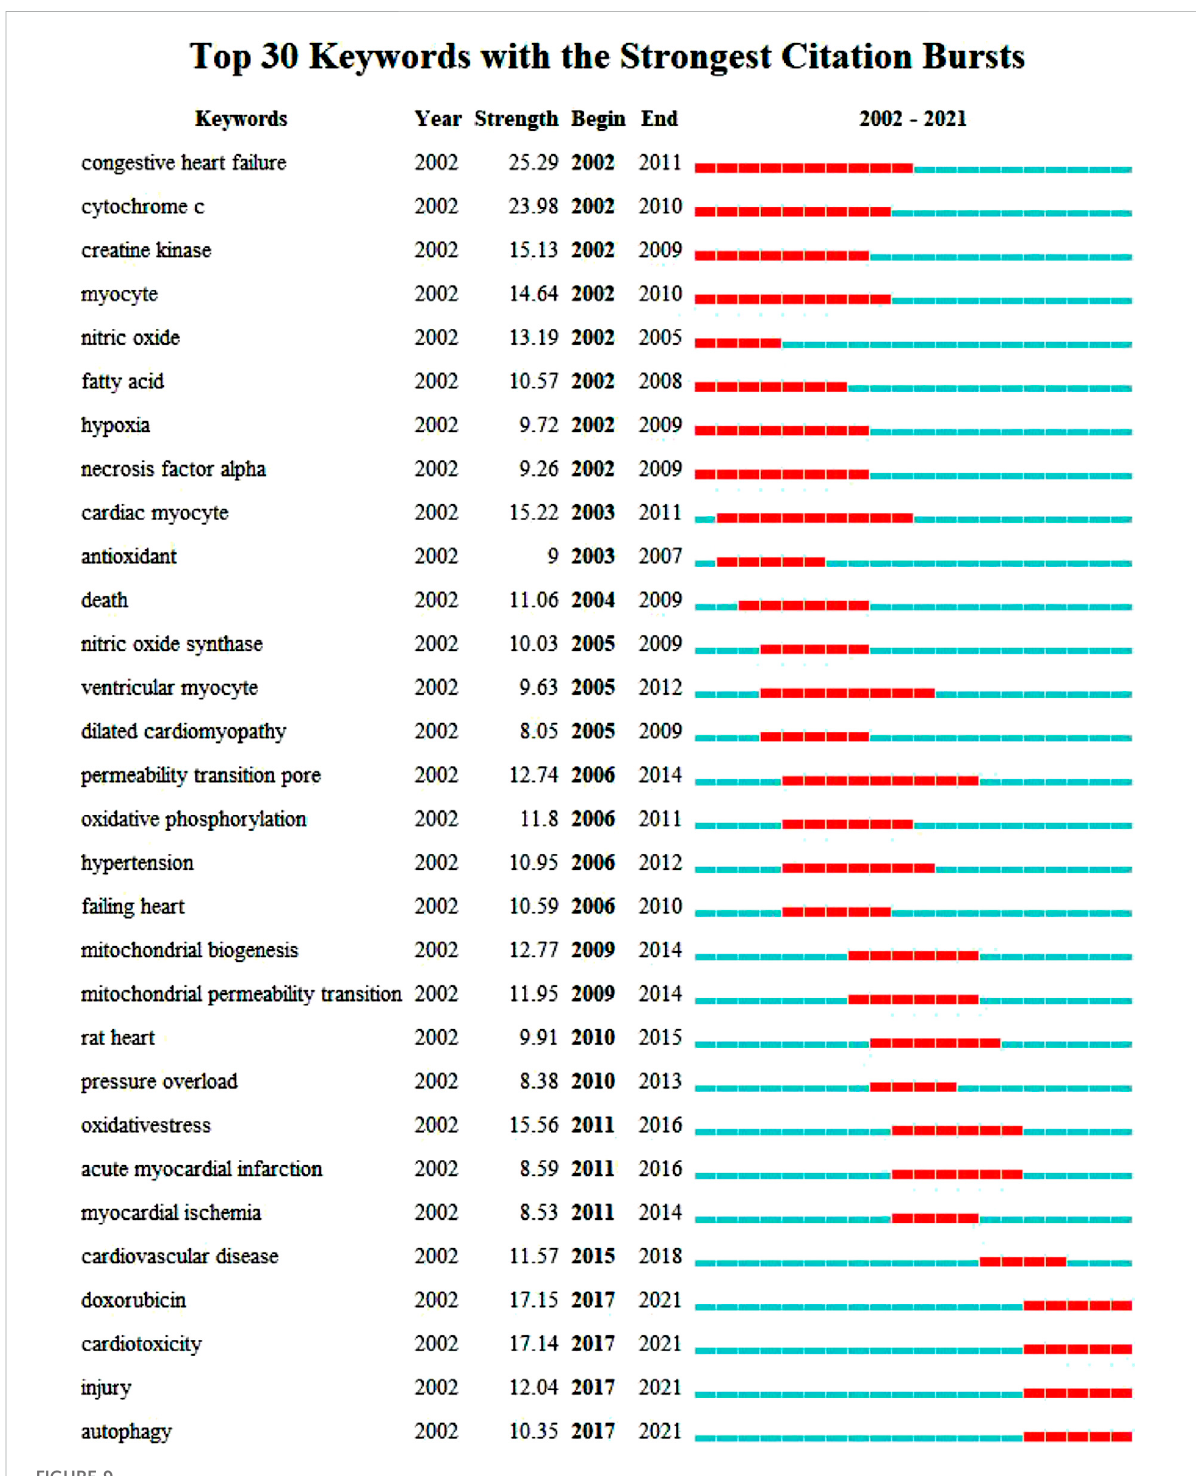
FIGURE 9 CiteSpace visualization map of top 30 keywords with the strongest citation